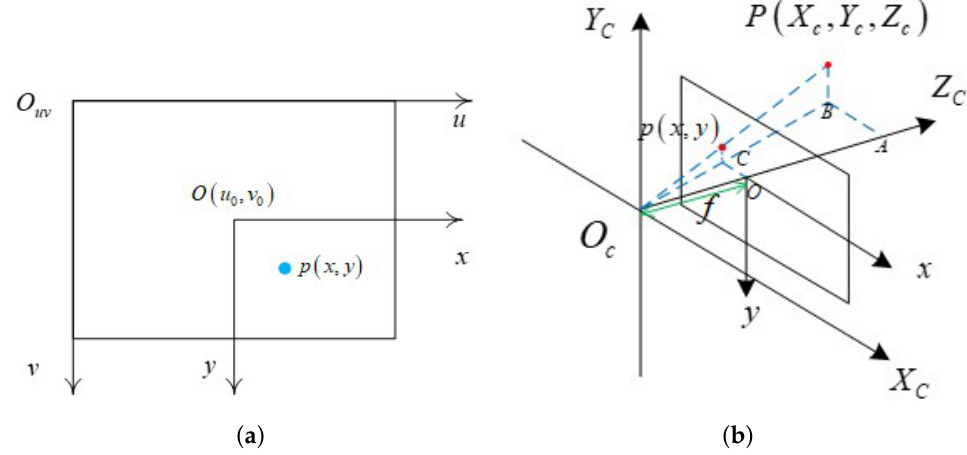
Figure 6. Schematic diagram of coordinate system. ( a ) Pixel coordinate system. ( b ) Camera coordinate system.